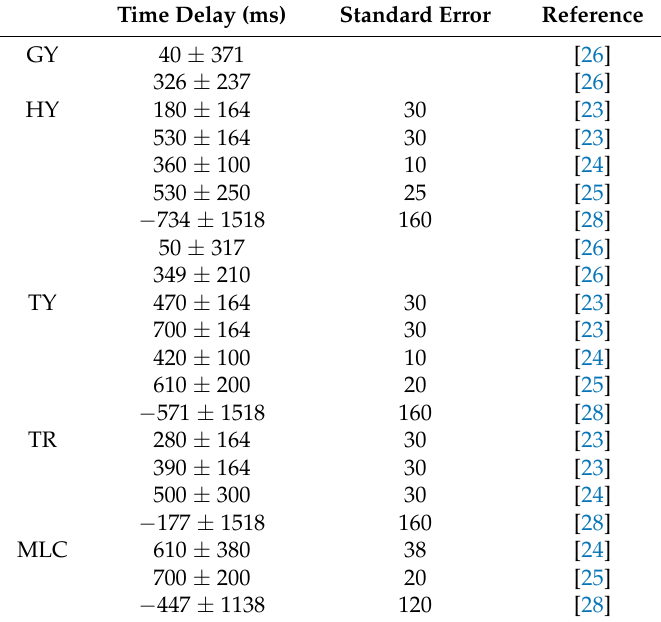
Table 3. Time delays (mean ± standard deviation) from a reference event in a preparatory step to turn onsets on different variables (GY, HY, TY, TR, MLC) collected from references specified in Column 4. When not provided in the original paper, the standard deviation was estimated from the reported standard error (Column 3) using the number of users and trials involved in the experiments as reported in Table 2-Column